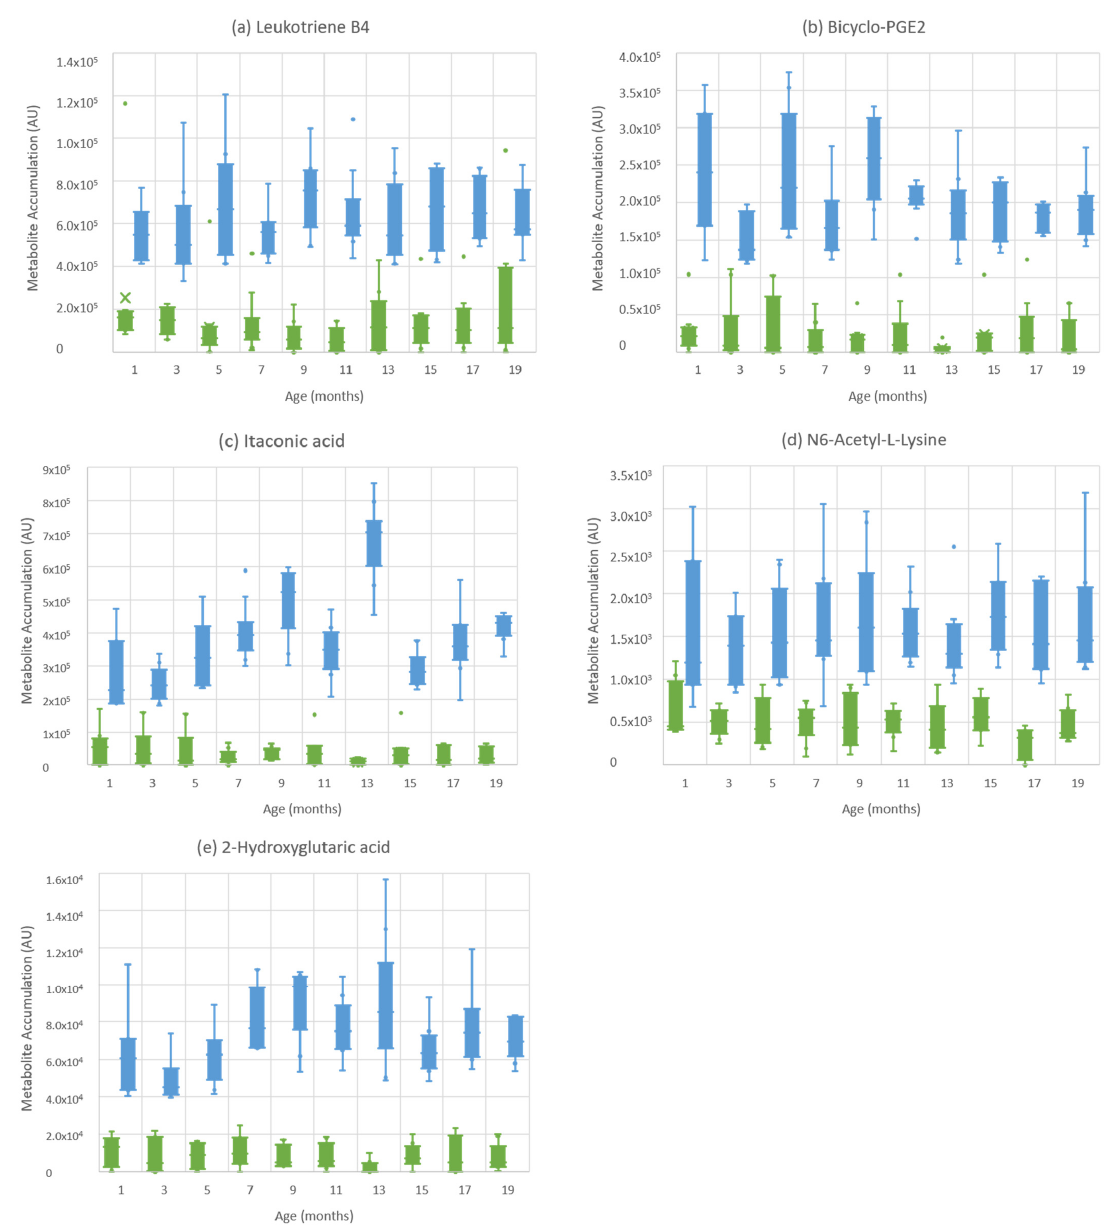
Figure 4. Box and whisker plots of metabolites which displayed minimal overlapping between naturally MAP-infected and control heifers, aged ~1 month to 19 months. ( a ) Leukotriene B4; ( b ) bicyclo-PGE2; ( c ) itaconic acid; ( d ) N6-acetyl-L-lysine ( e ) 2-hydroxyglutaric acid. Blue boxplots = naturally MAP-infected heifers, green boxplots = control heifers.